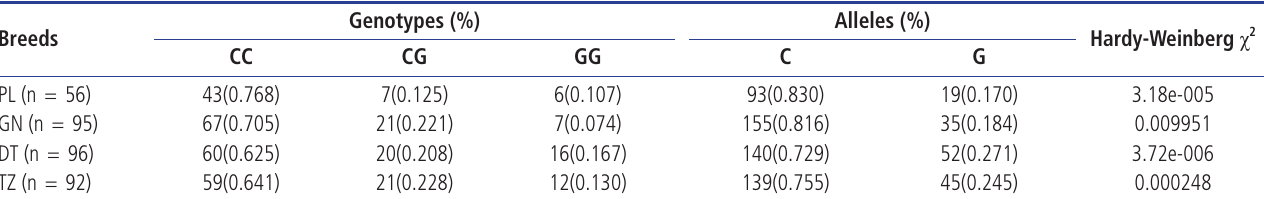
Table 4. Allele and genotype distribution of single-nucleotide polymorphism rs4331 C → G in the four yak breeds Breeds